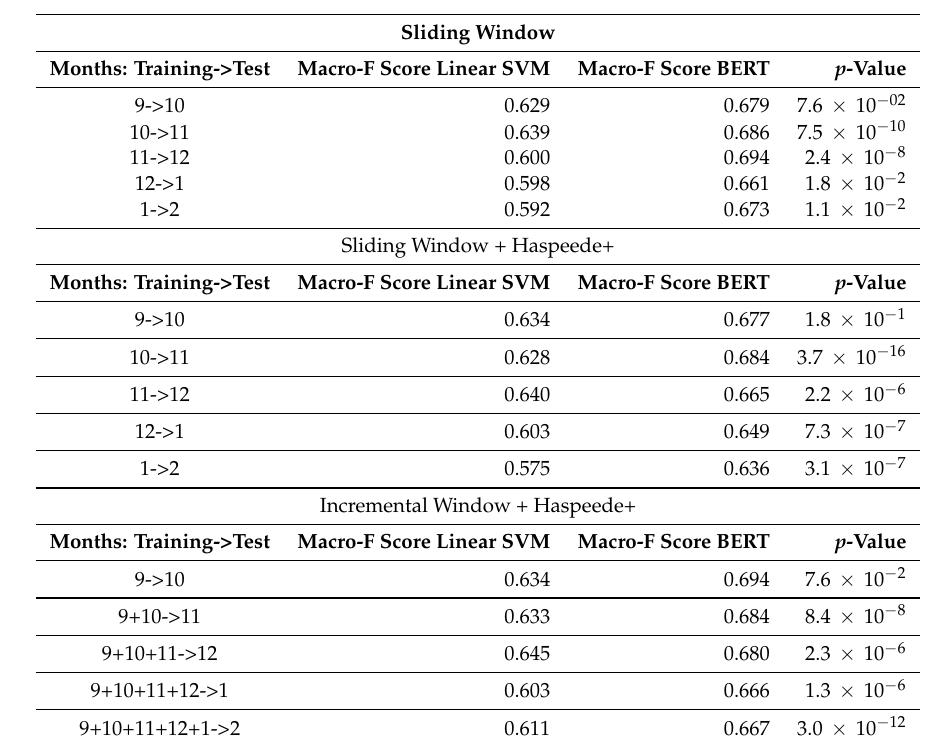
Table 9. Wilcoxon Test p